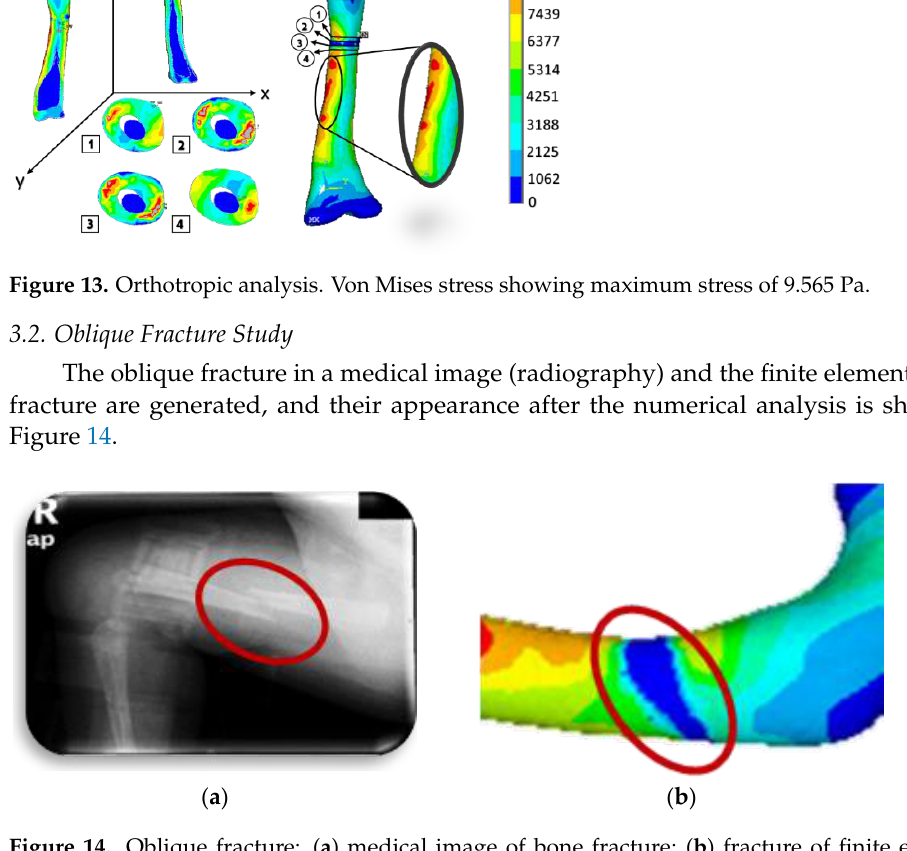
Figure 12. Transverse fracture: ( a ) medical image of bone fracture; ( b ) fracture of finite elements generated on the model.